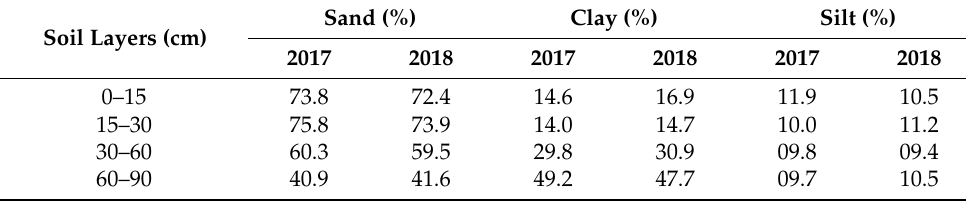
Table 1. Average physical characteristics of soil (0–90 cm depth) at